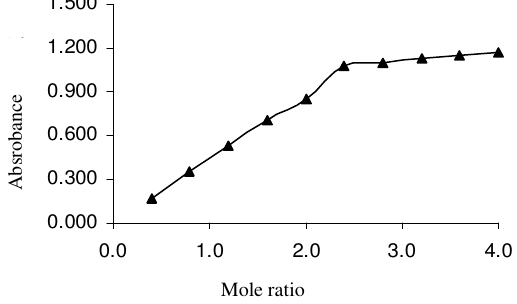
Figure 2. Mole-ratio method (Cd(II)-HBBrPT